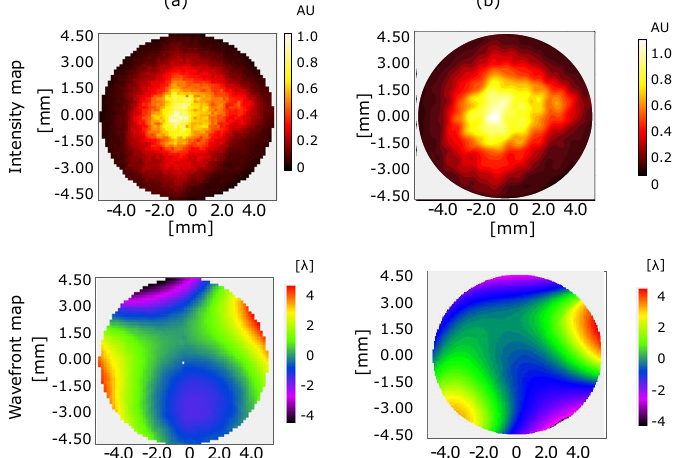
Figure 6. Intensity and wavefront map of direct beam obtained with ( a ) centroid and ( b ) Fourier demodulation reconstruction methods.